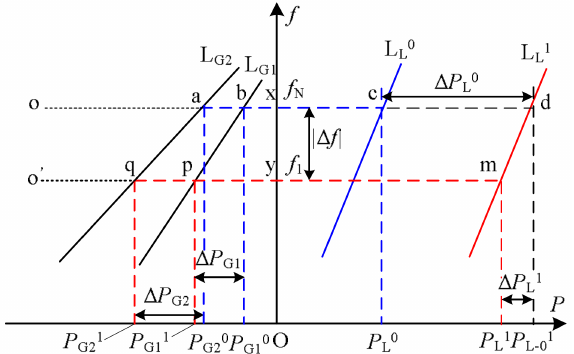
Figure 7. S-L analysis method of double